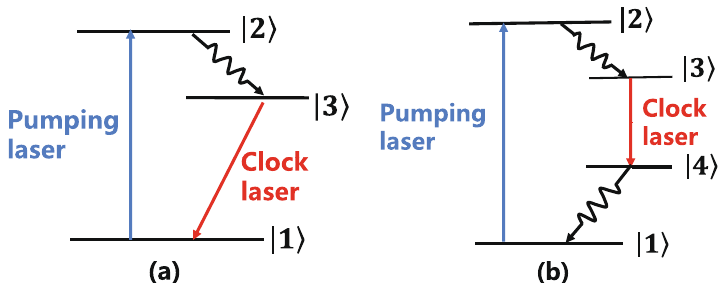
Fig. 4 Simplified energy level diagram of (a) three-level and (b) four-level AOC